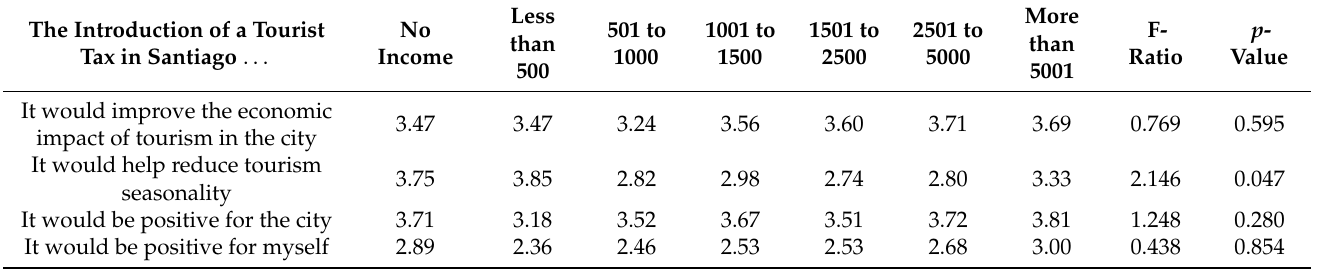
Table 5. Perception of the implementation of the tourist tax according to the level of income.